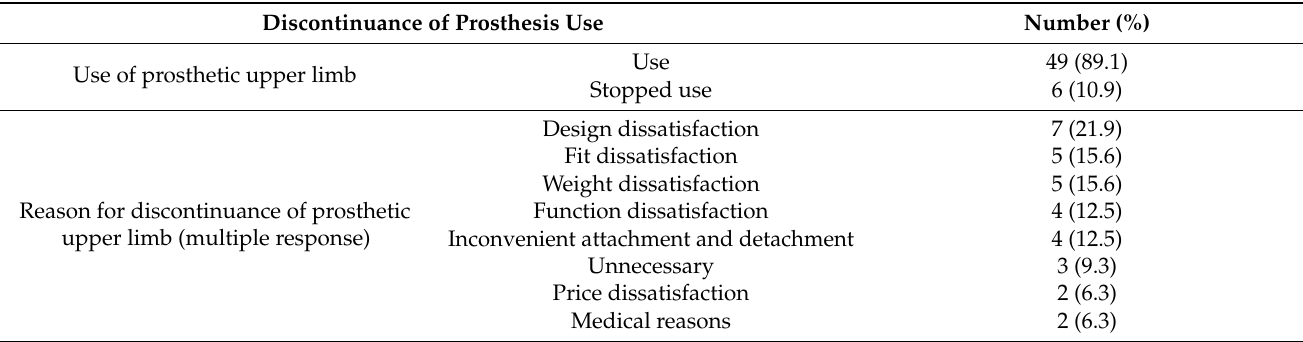
Table 3. Discontinuance of prosthesis.